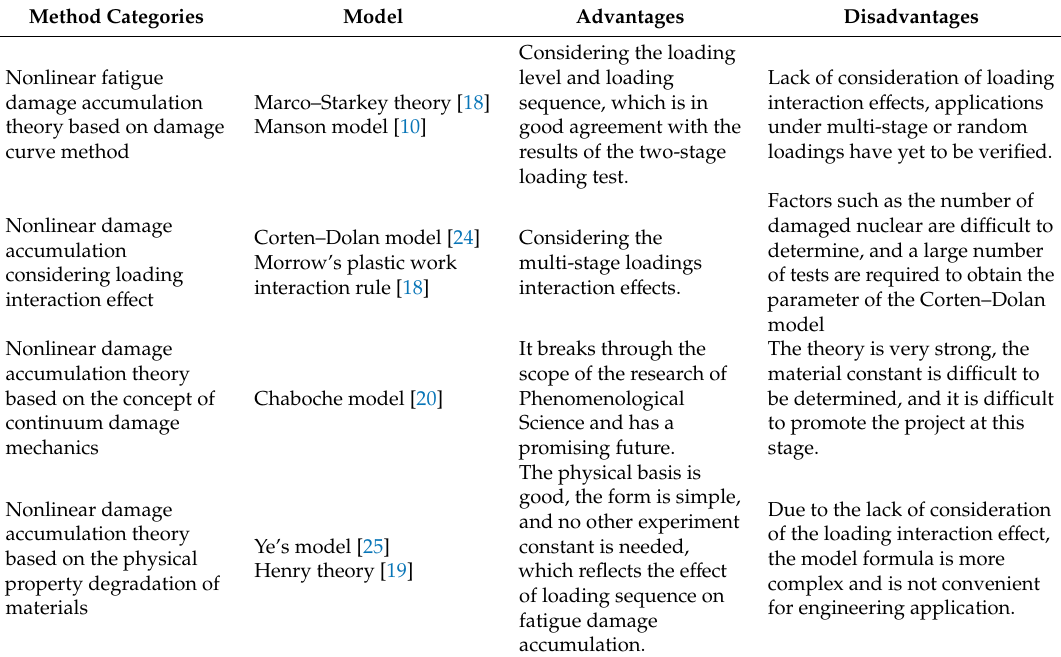
Table 1. Nonlinear damage accumulation